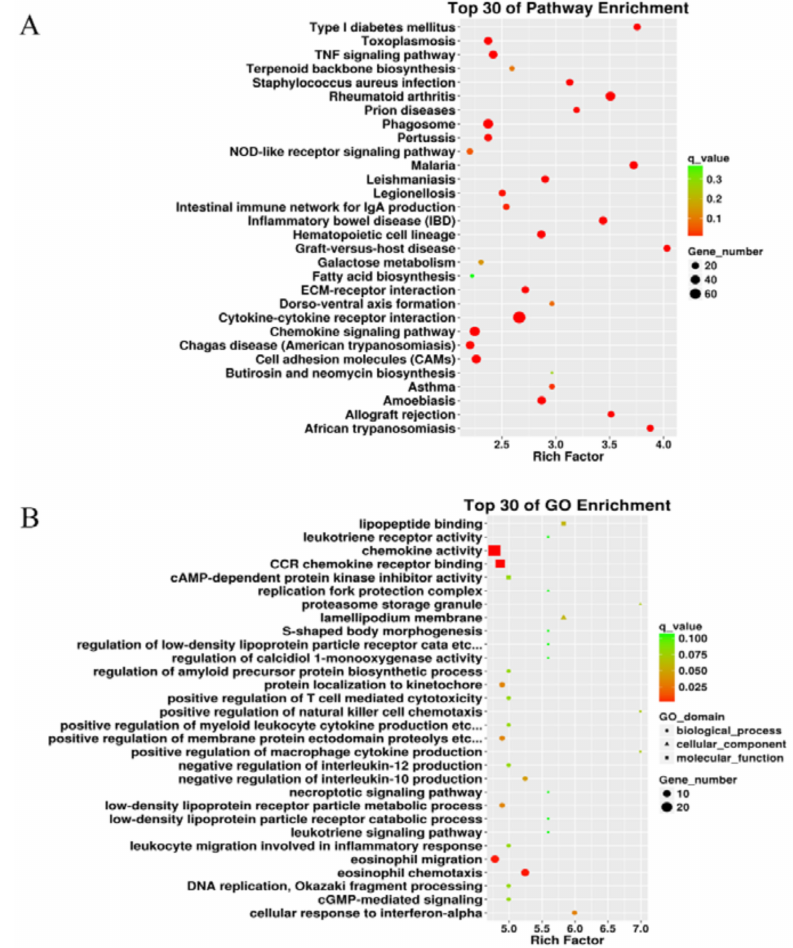
Figure 4. Analysis of the top 30 pathway enrichment ( A ) and gene ontology (GO) enrichment ( B ) by